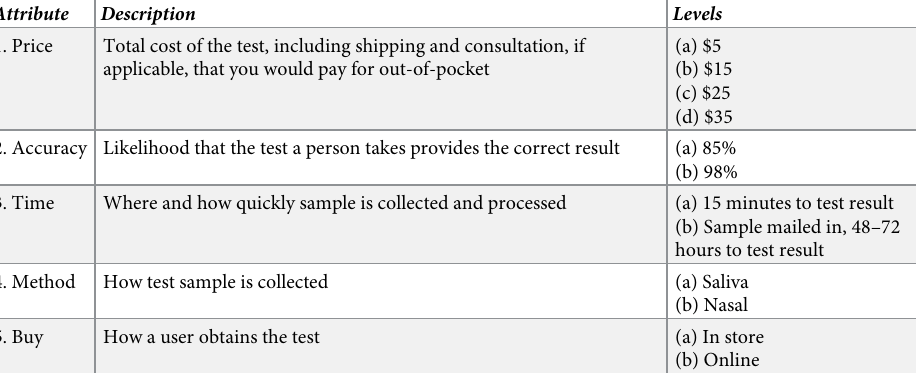
Table 1. List of attributes and levels used in the conjoint-analysis